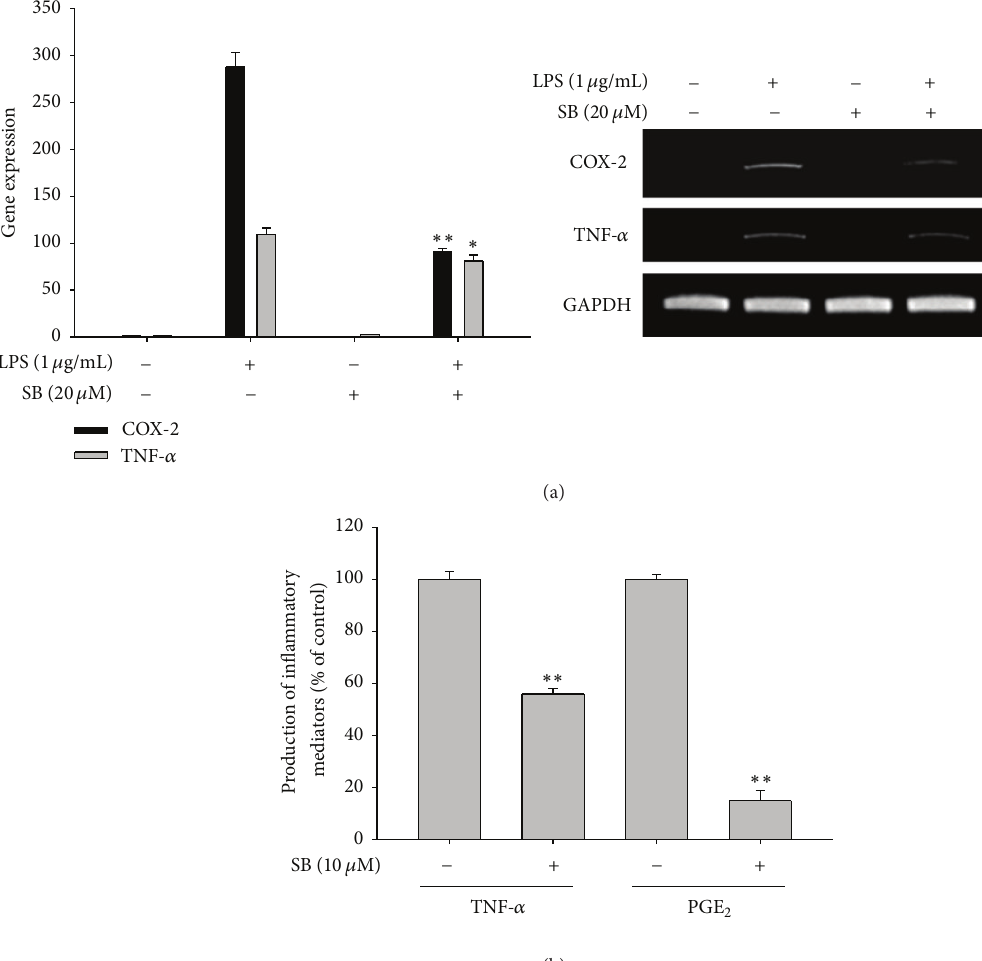
Figure 5: Effect of SB203580 on the expression of COX-2 and TNF- 𝛼 mRNA and the production of TNF- 𝛼 and PGE 2 . ((a) and (b)) The levels of COX-2 and TNF- 𝛼 mRNA were determined using semiquantitative RT-PCR or real-time PCR. (a) The levels of TNF- 𝛼 and PGE 2 were determined using ELISA and EIA on culture supernatants from RAW264.7 cells that had been treated with SB203580 (20 𝜇 M) and LPS (1 𝜇 g/mL) for 6h (TNF- 𝛼 ) or 24h (PGE 2 ) h. ∗ P < 0.05 and ∗∗ P < 0.01 compared to